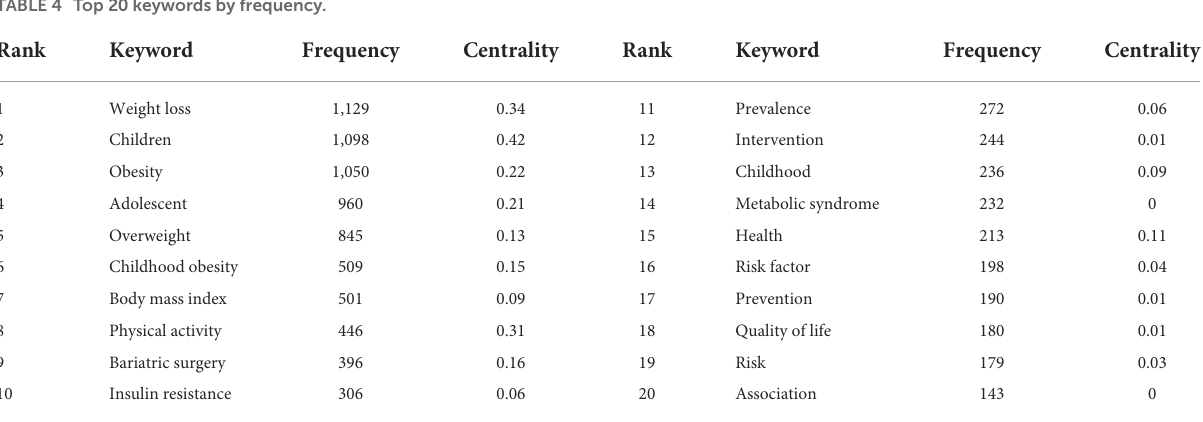
TABLE 4 Top 20 keywords by